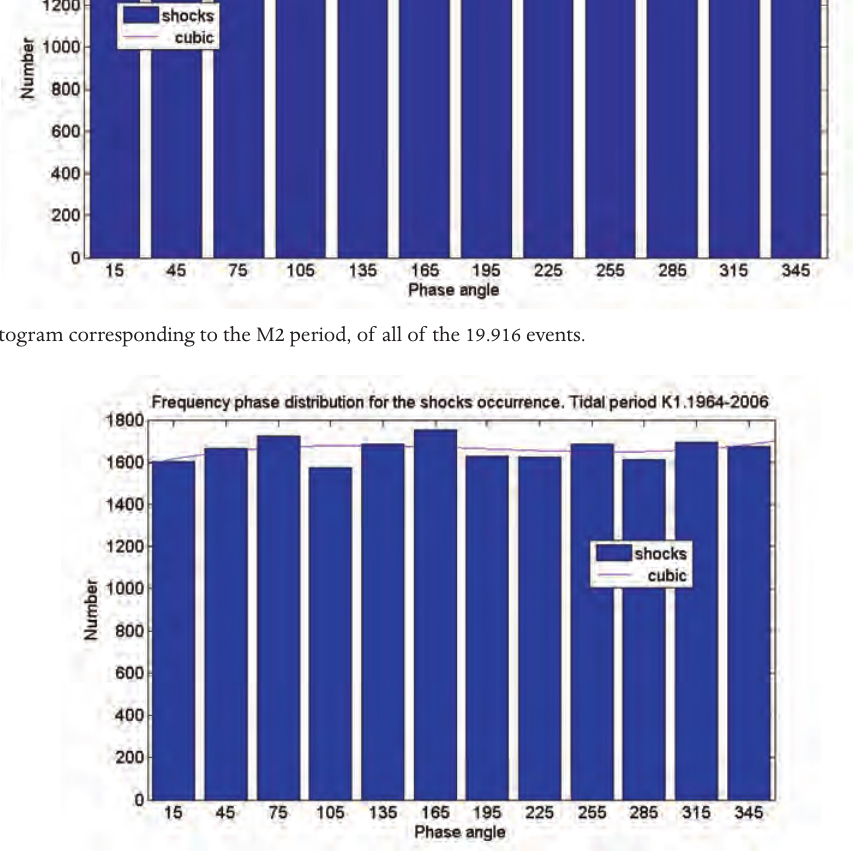
Figure 5. Cumulative histogram corresponding to K1 period, of all of the 19.916